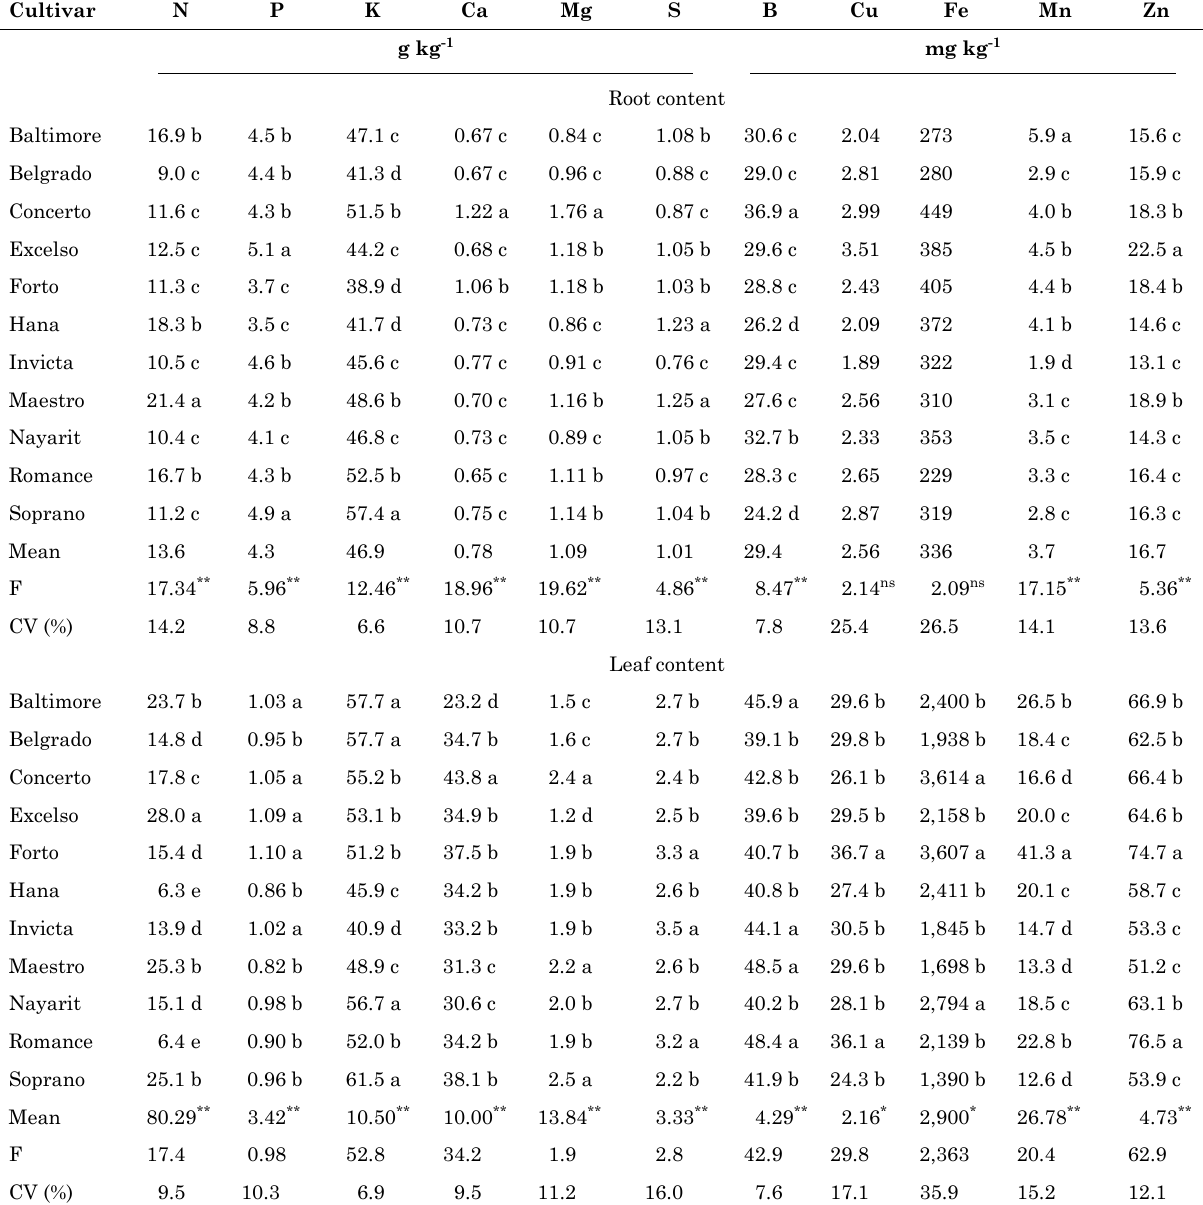
Table 7. Nutrient contents in the roots and leaves of winter carrot cultivars sown in the summer-winter transition crop season (Experiment